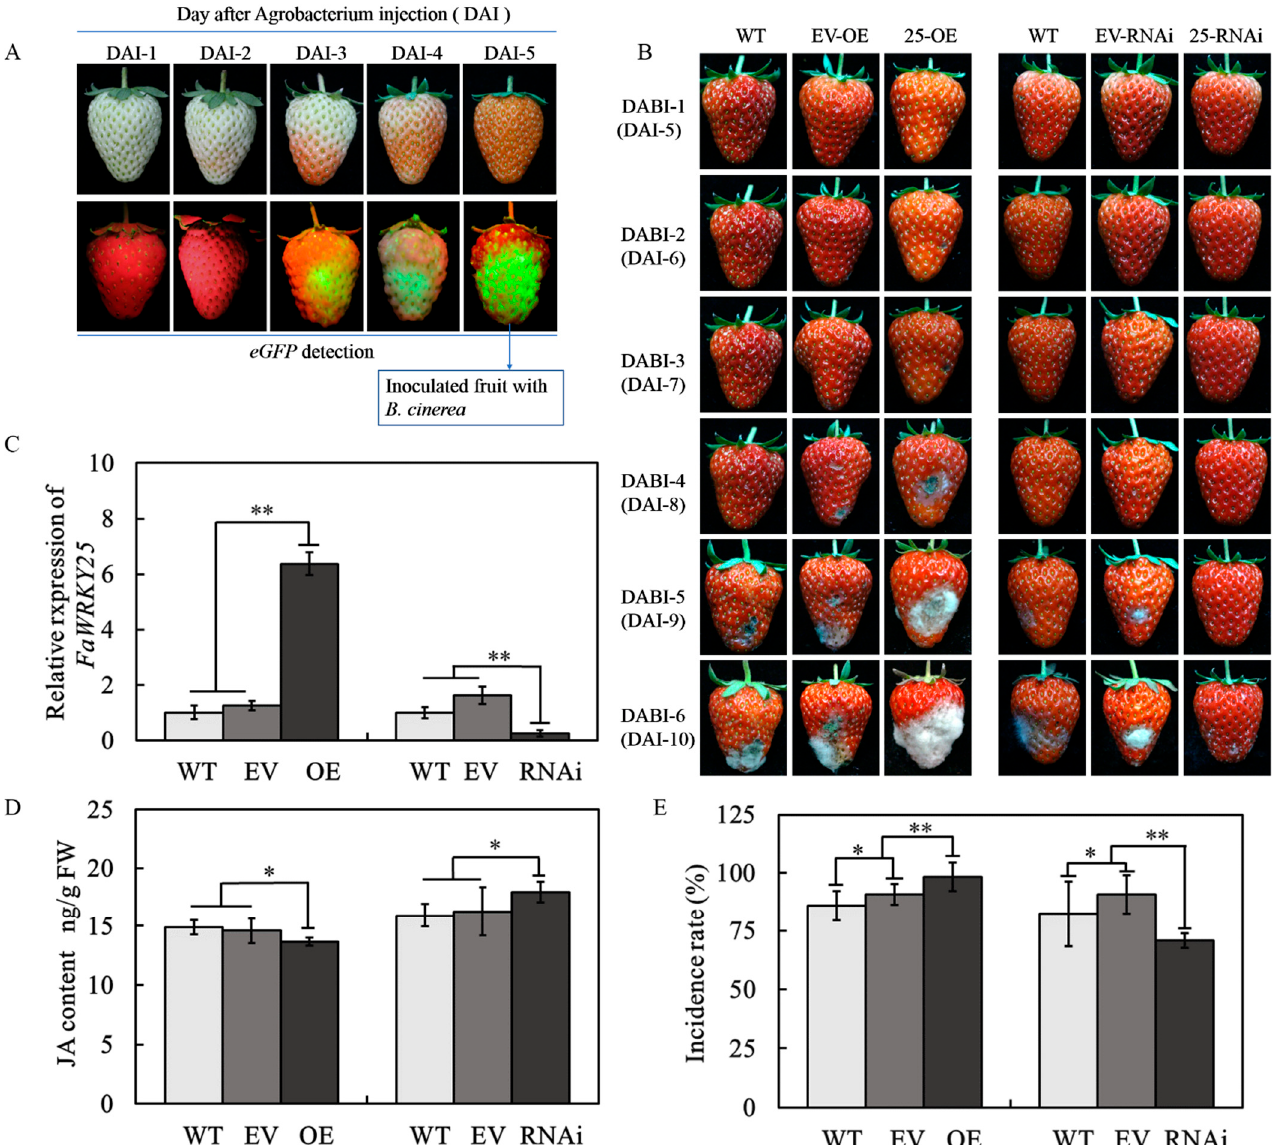
Figure 3. Effect of FaWRKY25 -OE (-overexpression) and -RNAi (-ribonucleic acid interference) on the levels of FaWRKY25 transcript and JA. ( A ) Expression of green fluorescent protein (eGFP) after Agrobacterium tumefaciens injection. ( B ) Phenotypes of FaWRKY25 -OE and FaWRKY25 -RNAi strawberry fruits after Agrobacterium tumefaciens injection and Botrytis cinerea inoculation. DABI denotes days after Botrytis cinerea inoculation, and DAI denotes days after Agrobacterium tumefaciens injection. ( C ) Effect of FaWRKY25 -OE and -RNAi on FaWRKY25 relative expression 5 days after Agrobacterium tumefaciens injection (DAI-5). ( D ) Effect of FaWRKY25 -OE and -RNAi on jasmonic acid levels 5 days after Agrobacterium tumefaciens injection (DAI-5). ( E ) Comparison of the incidence rate in FaWRKY25 -OE and FaWRKY25 -RNAi strawberry fruits after Botrytis cinerea inoculation at DABI-6. Values are means ± SD of three biological replicates. Asterisks above the columns denote a significant difference at * p < 0.05 and ** p < 0.01 levels according to Student’s t -test. The B. cinerea infection test was performed on the fruits with transient gene transfor-